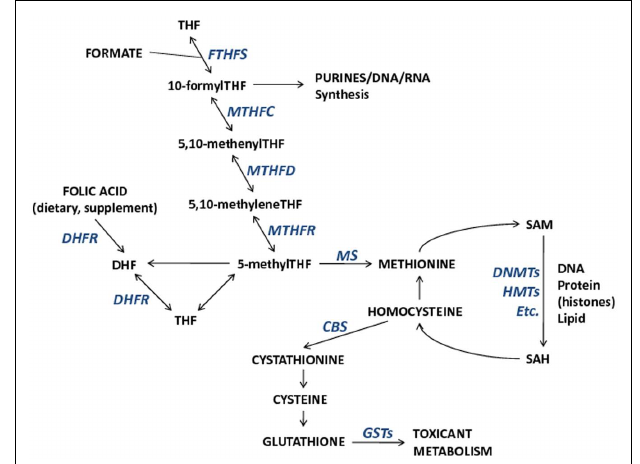
FIGURE 1 |The relationships among metabolic components involved in one-carbon metabolism and important for DNA synthesis, DNA methylation, and toxicant metabolism. Enzymes that participate in metabolic reactions appear italicized in blue. Metabolic component abbreviations: tetrahydrofolate (THF), dihydrofolate (DHF), S-adenosyl-methionine (SAM), S-adenosyl-homocysteine